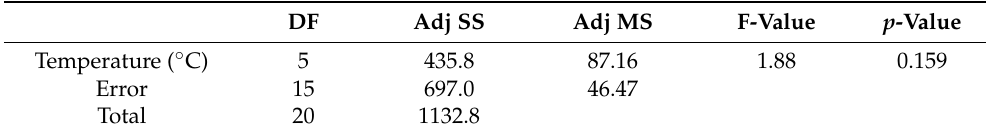
Table 2. Analysis of variance for the effect of extraction temperature on the psicose stability.